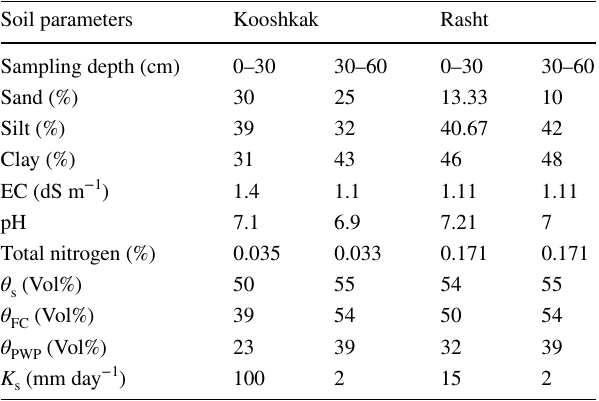
Table 2 Soil parameters of the experimental sites Soil parameters